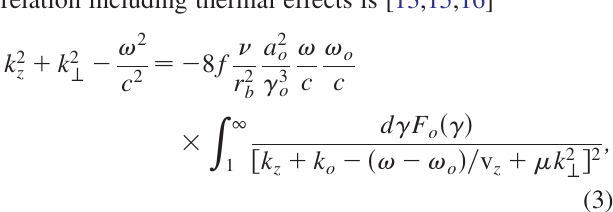
FIG. 2. (Color) X-ray ( (cid:2) ¼ 20 (cid:1)A ) power gain length L beam current for a cold electron beam with electron beam radius ¼ 70 (cid:1) m (red) and r ¼ 100 (cid:1) m (blue). The curves are r b b ¼ 1 = (cid:2) and the solid circles are from from Eq. (6) with L go go GENESIS simulations. The other parameters are a o ¼ 0 : 5 , (cid:2) o ¼ ¼ 5 : 88 MeV . 1 (cid:1) m , and E b